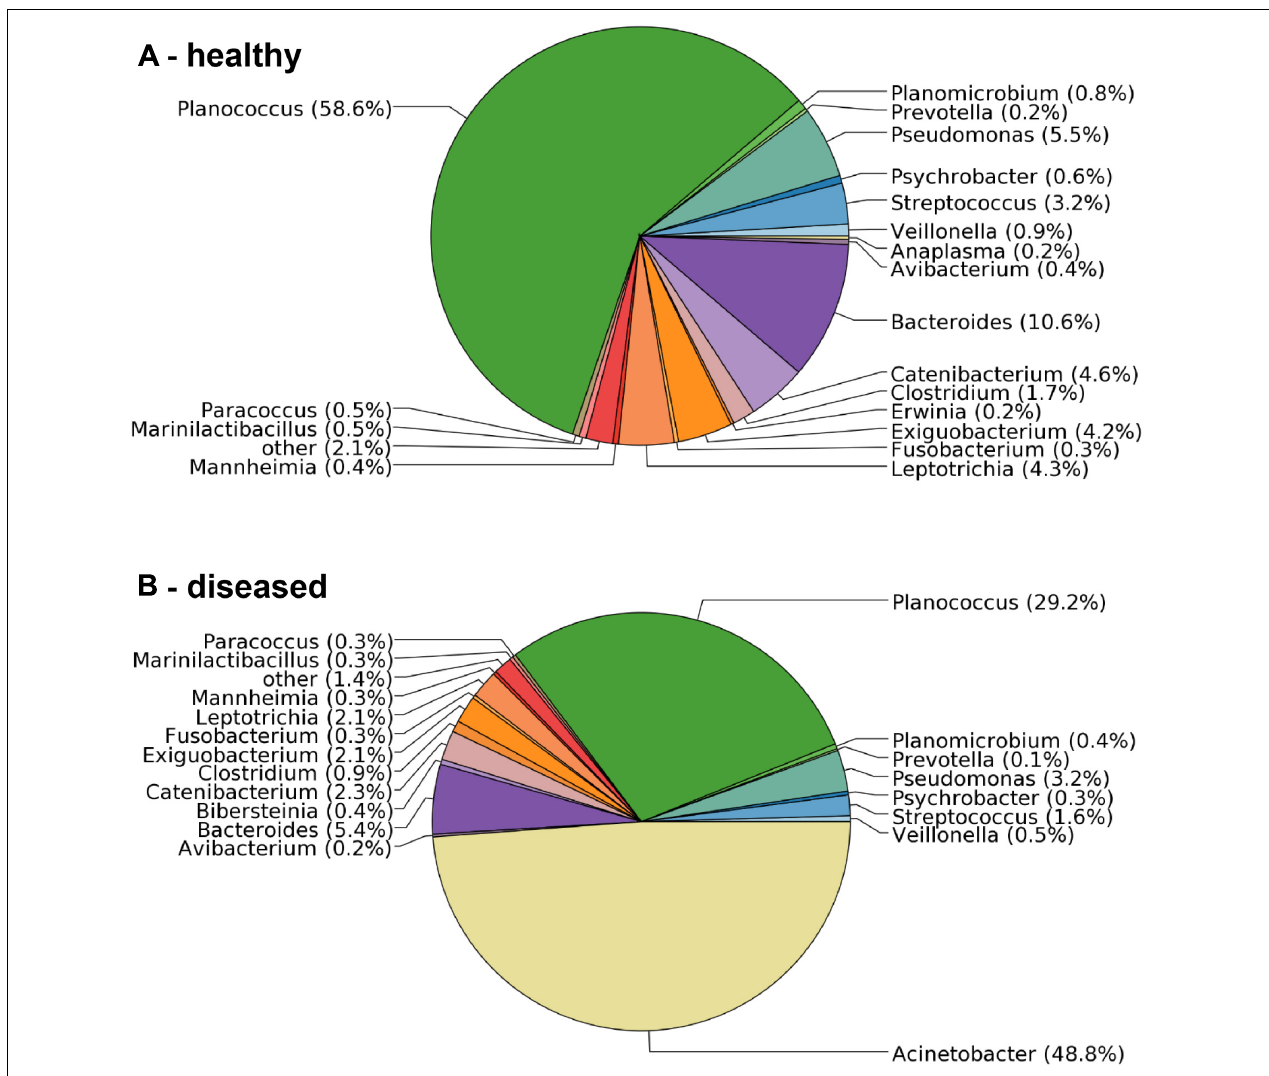
FIGURE 1 | Distribution of microbial taxa in BAL samples obtained from healthy and diseased sheep. (A) The bronchia of healthy sheep contained bacteria from 69 genera. (B) Samples from diseased animals were dominated by sequencing reads assigned to the genus Acinetobacter, which were not found in samples from healthy